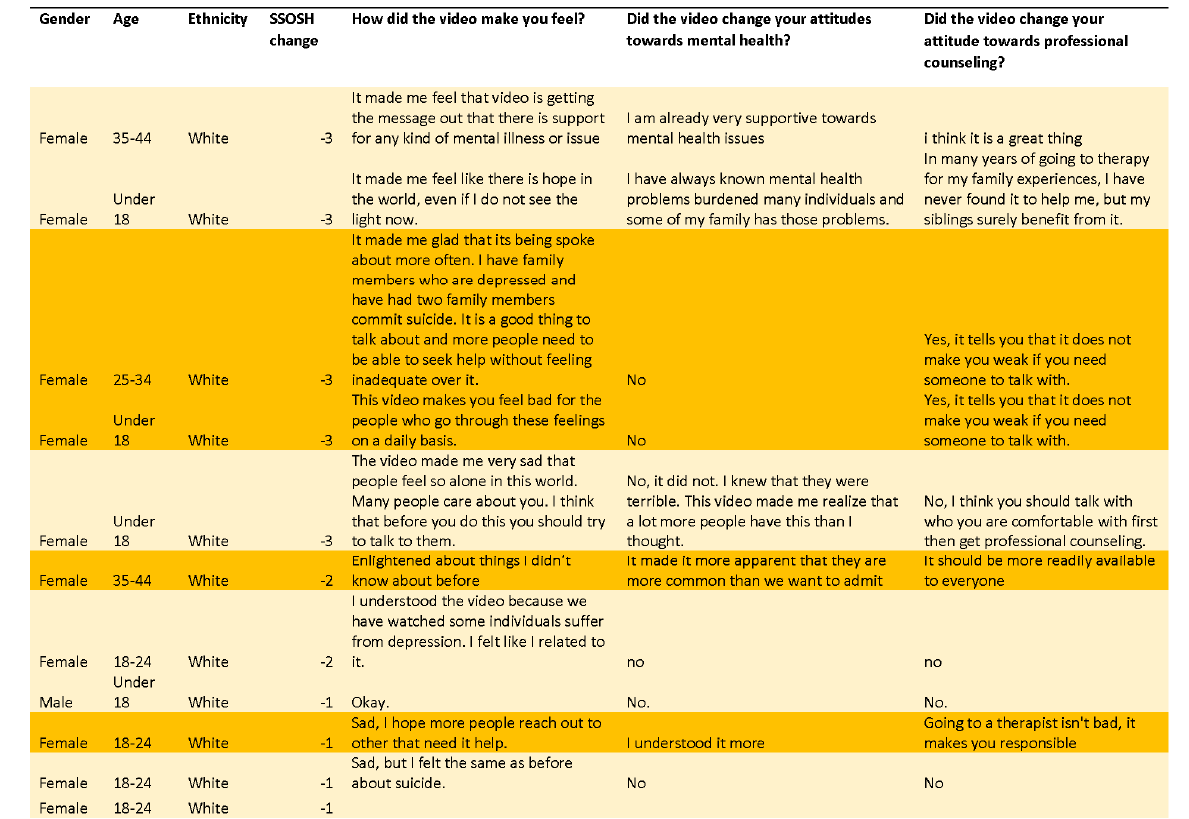
Figure 4. Group 1: large stigma reductions (respondents with stigma reductions > 3, i.e., a score change from − 4 to − 10). Participants were divided into two groups: those who reported increased openness to help-seeking (dark orange) and those who reported no change in attitudes towards counseling (light orange).